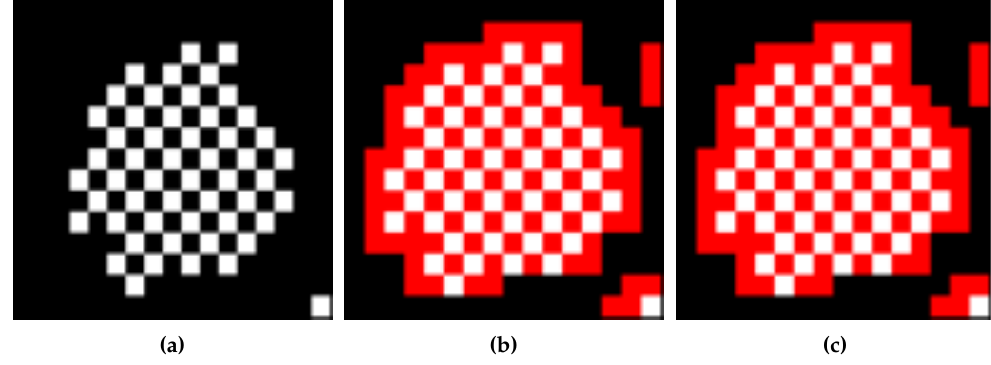
Figure 21. Example of untraced contour pixels caused by missing starting pixel CCITT Image #9 From ( 1093,1766 ) to ( 1108,1780 ) . ( a ) Original image; ( b ) traced by ISBF; ( c ) traced by the proposed algorithm.